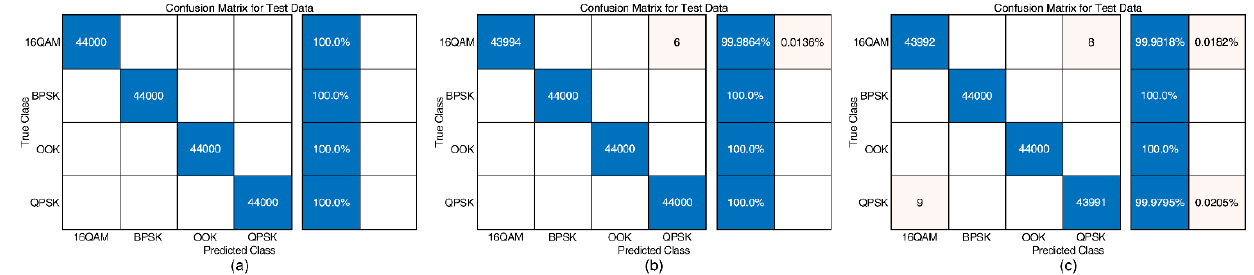
Figure 10. Confusion matrix for test data for different turbulence strength: ( a ) weak, ( b ) moderate, and ( c ) strong.